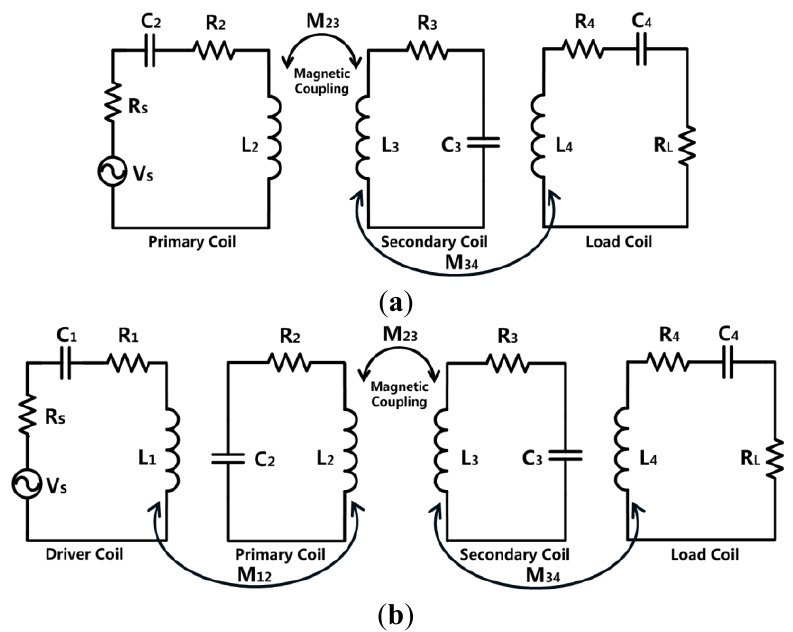
Figure 3. ( a ) Equivalent circuit model of system architecture with three coils; ( b ) equivalent circuit model of system architecture with four coils. The cross-coupling effects between non-adjacent coils are neglected in Figure 3a,b for